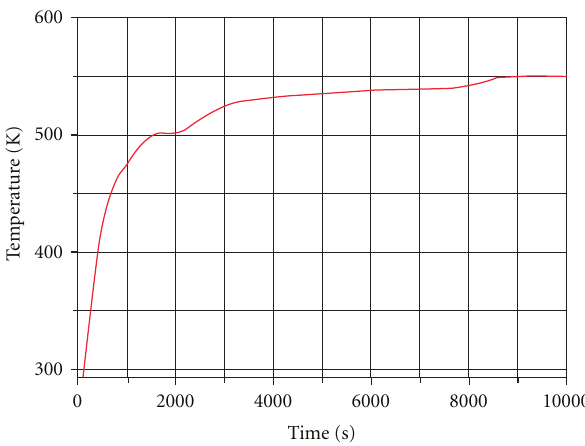
Figure 3: Volume-averaged temperature of the steam-hydrogen-air mixture for adiabatic boundary